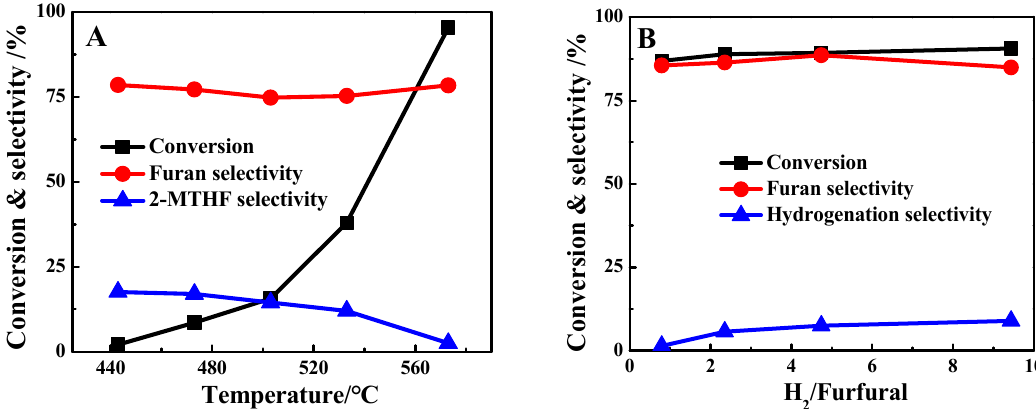
Figure 6. Furfural conversion, furan selectivity and hydrogenation product selectivity over 1%Pt/SBA-15 pH = 6C at the first hour of the reaction as a function of ( A ) temperature (H 2 /furfural (mol) = 2.4, WHSV = 16.5 h − 1 ) and ( B ) H 2 /furfural (mol) (573 K, WHSV = 16.5 h − 1 ). Table 2. Comparison of catalytic results between our study and other studies.